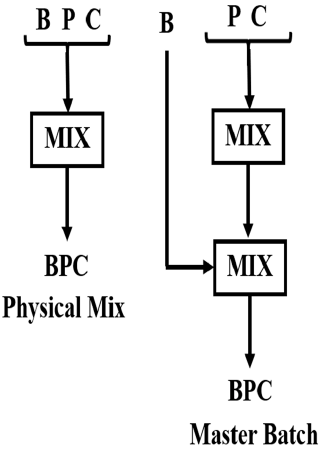
Figure 11. Schematic representation of the two mixing processes: physical mix and master batch (reprinted from [46] with the permission of Elsevier).